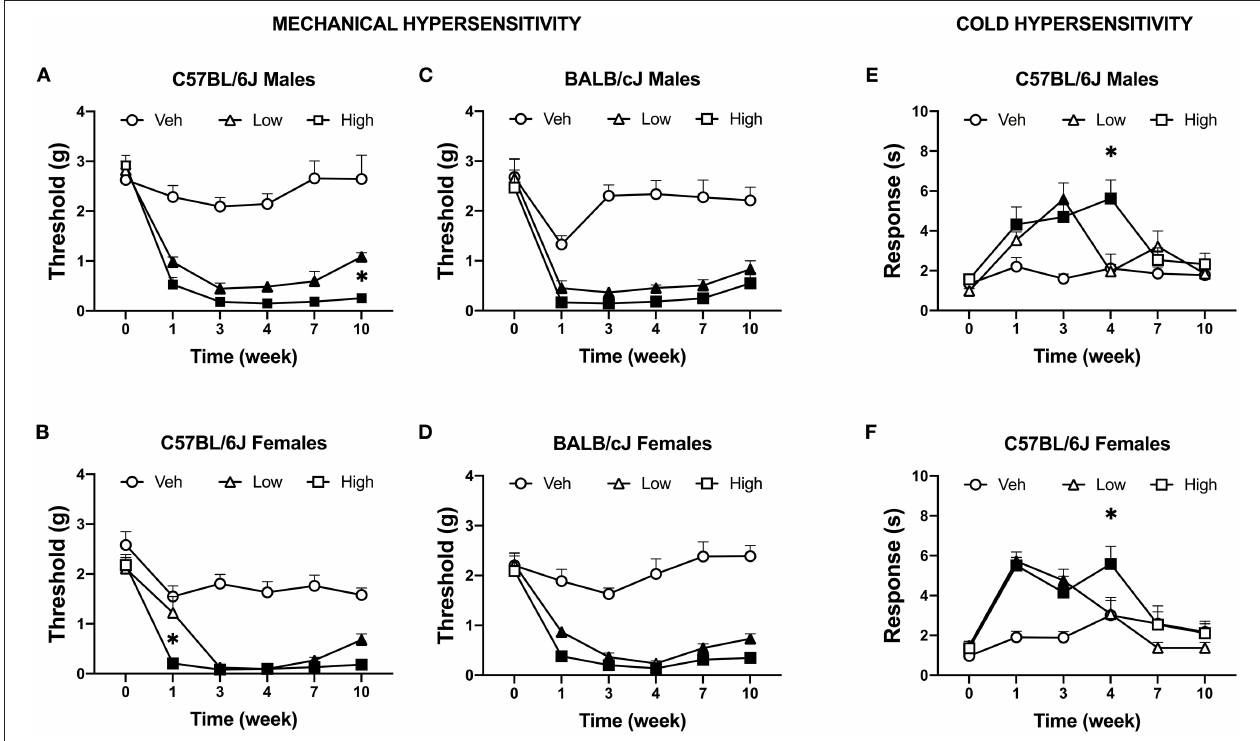
FIGURE 3 | Induction of mechanical and cold hypersensitivity by low and high dose of oxaliplatin. Development of mechanical hypersensitive was monitored after each regimen of oxaliplatin (5 injections of 0.3 or 3 mg/kg) with the von Frey test in C57BL/6J males ( n = 17/group) (A) , C57BL/6J females ( n = 11/group) (B) , BALB/cJ males ( n = 7–9/group) (C) , BALB/cJ females ( n = 10/group) (D) . Similarly, cold hypersensitivity was tested on the same week in in C57BL/6J males ( n = 8/group) (E) , C57BL/6J females ( n = 8/group) (F) . Values are expressed as mean ± SEM. Results were compared using two-way ANOVA (Treatment, Time